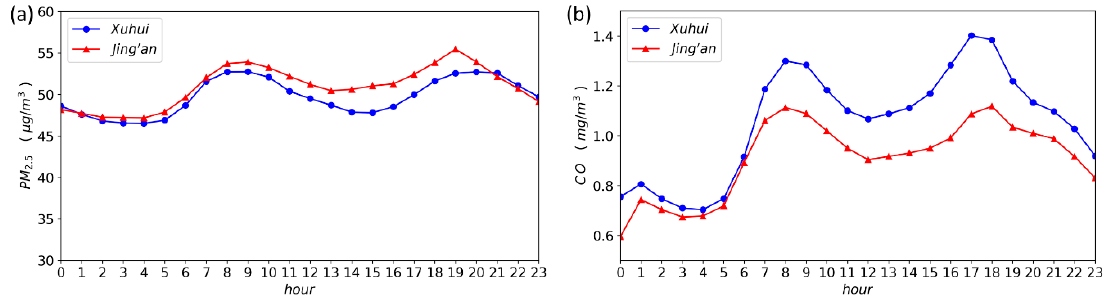
Figure 5. The diurnal variations of air quality data in the two monitoring stations. ( a ) PM 2.5 ( b ) CO.